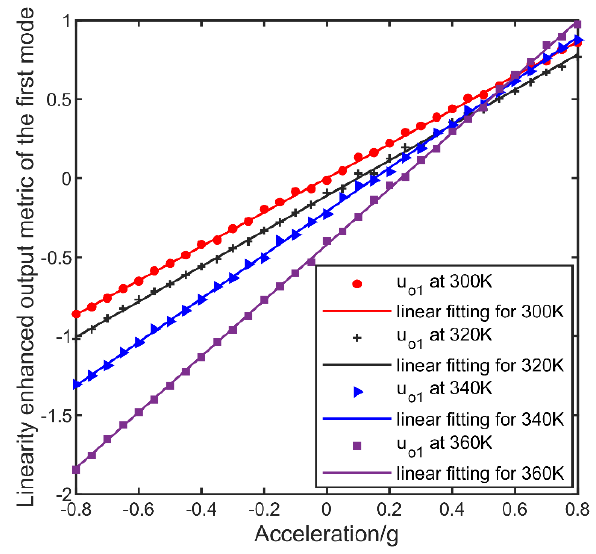
Figure 7. Data flow of the compensation process.